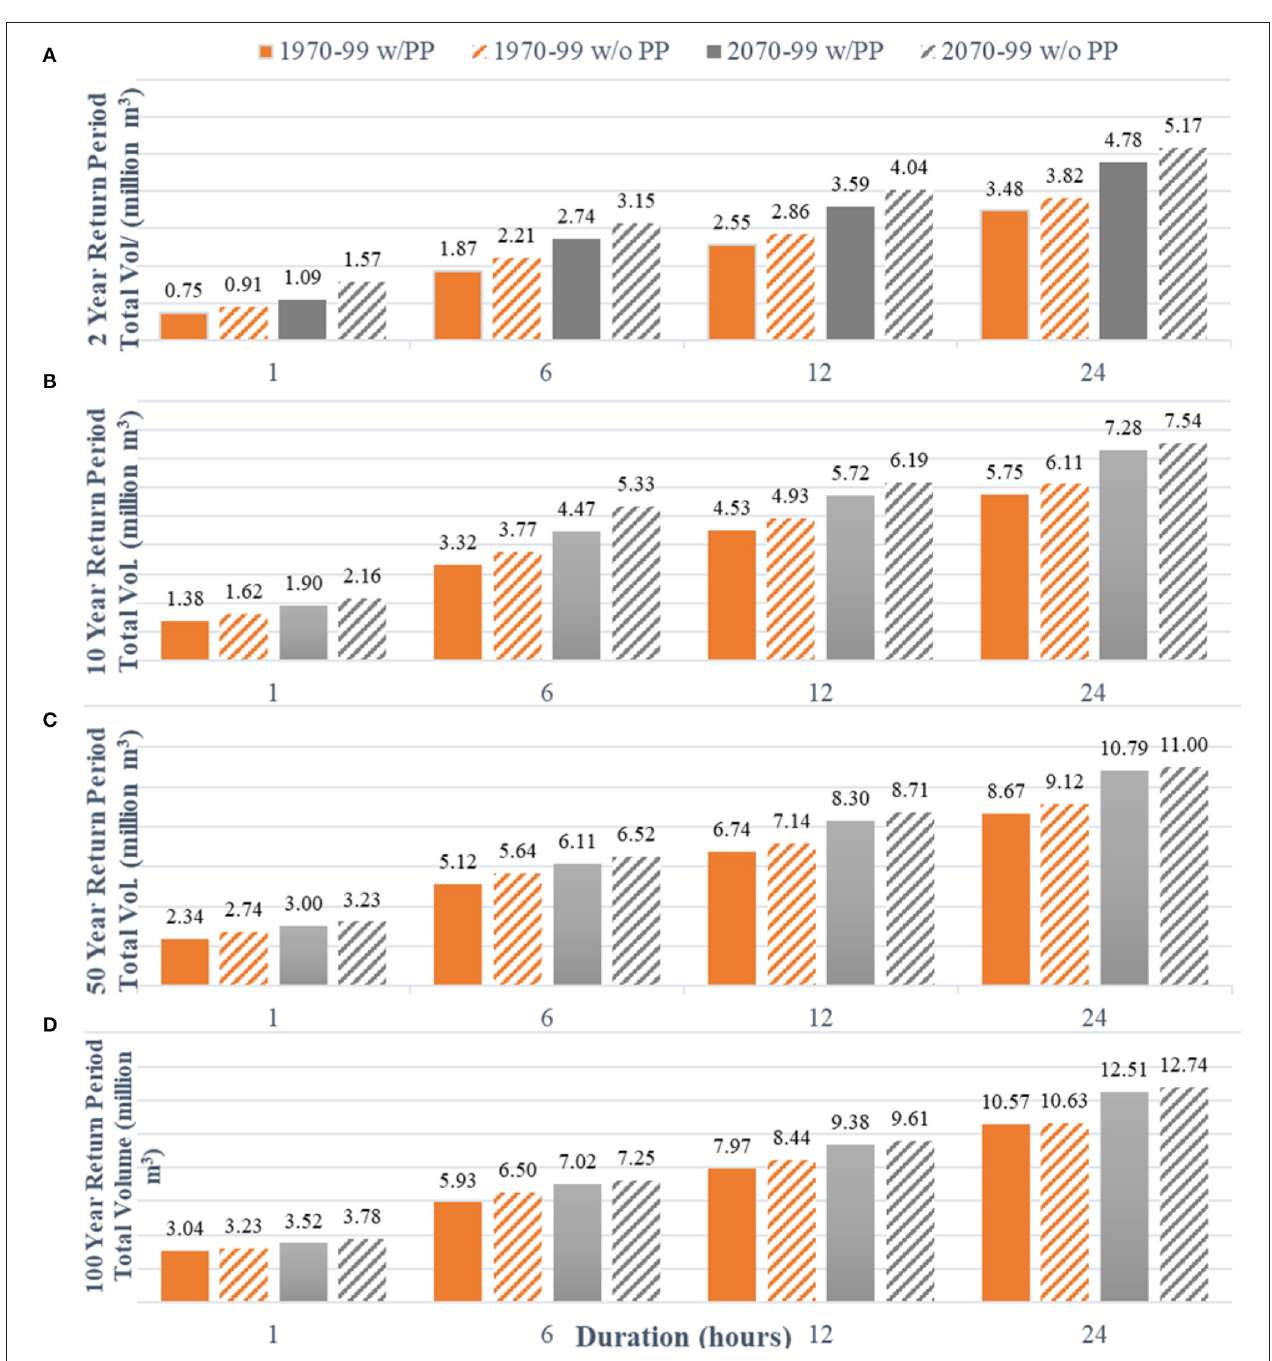
FIGURE 3 | Total CSO volumes in million m 3 for the 16 scenarios. Four durations, two timeframes, two installments -with or without PP, and four return periods. (A) 2-years. (B) 10-years. (C) 50-years. (D) 100-years. durations, which shows that in terms of CSO volume,